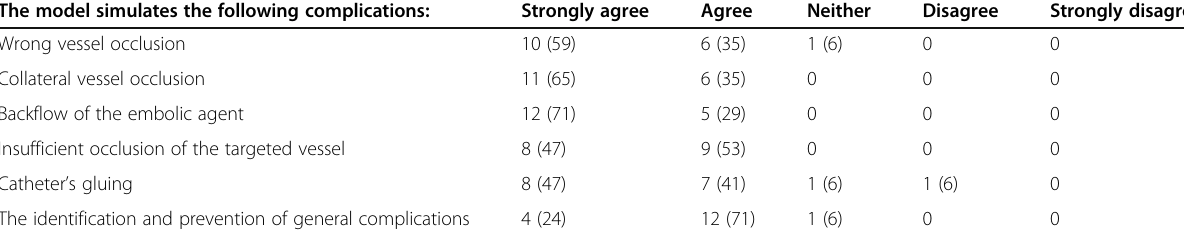
Table 2 Summarized answers of the participants to the questionnaire regarding the complications ( n = 17) The model simulates the following complications: Strongly agree Agree Wrong vessel